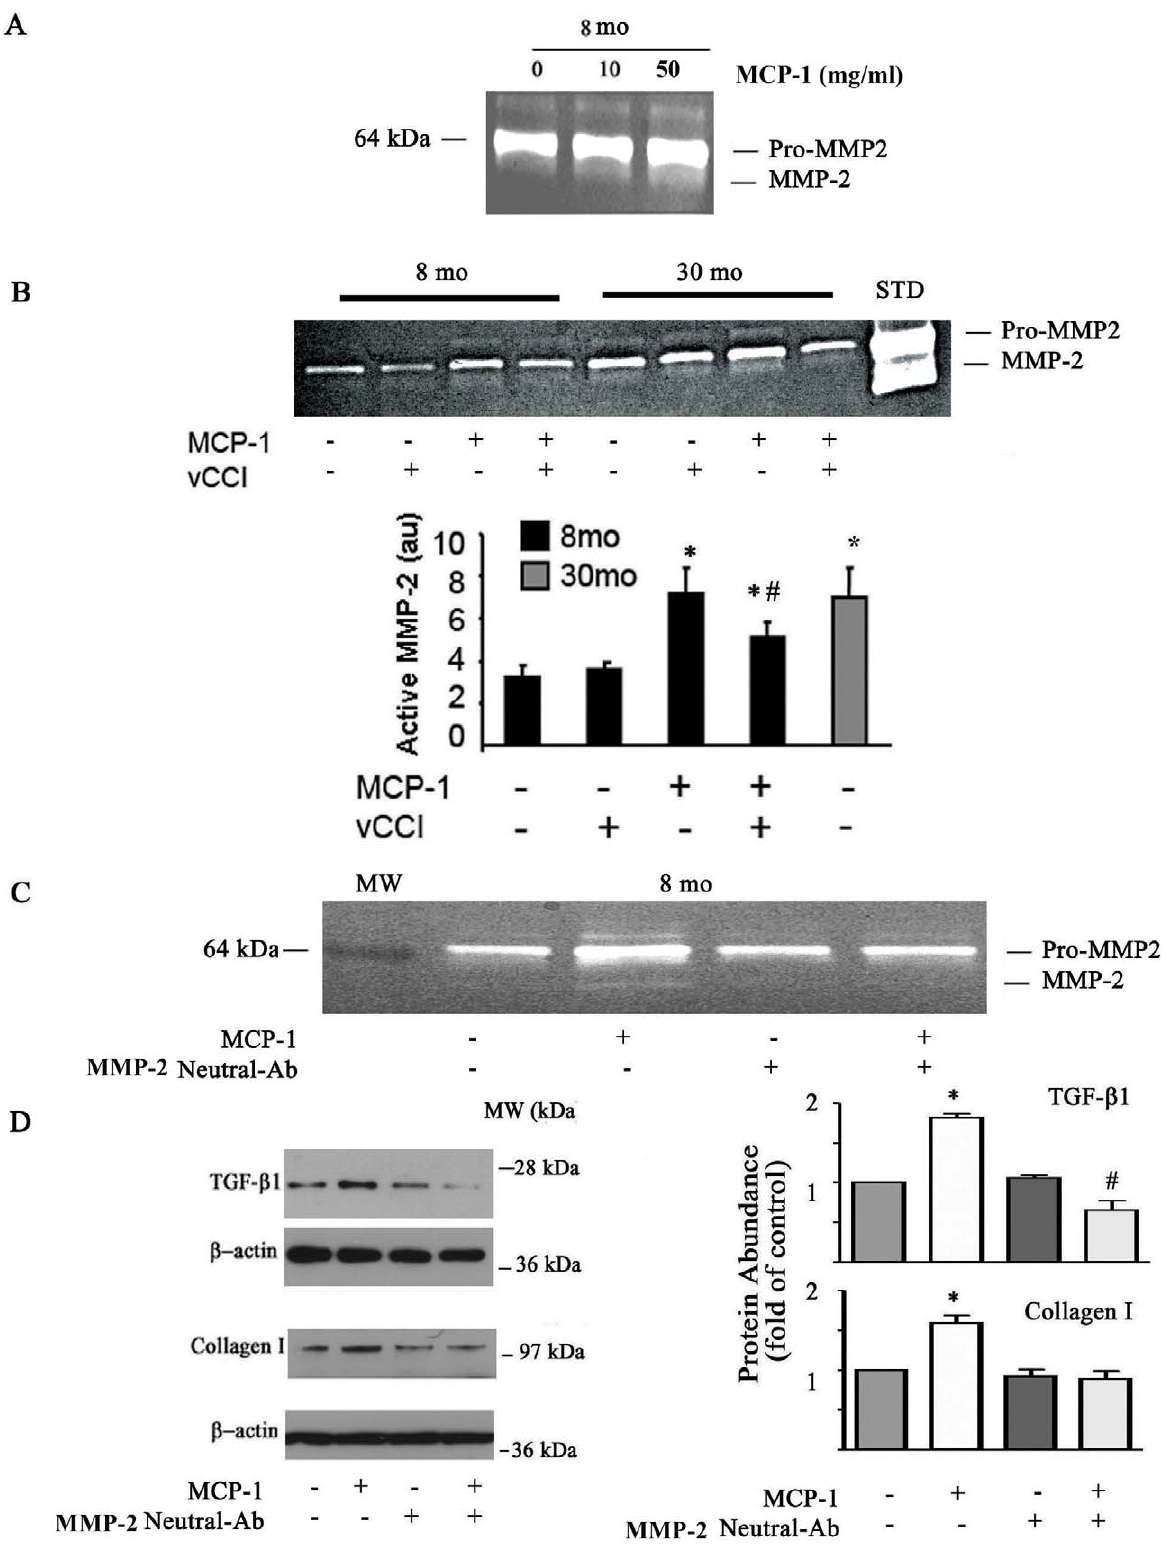
Figure 4. Profile of MMP-2, TGF- b 1 and downstream signaling molecules with aging and MCP-1 intervention. A . Gelatin zymograph. Early passage young VSMC were treated with or without MCP-1 for 24 hours. B. Gelatin zymograph (upper panel); and average data (lower panel). Early passage young and old VSMC were treated with or without MCP-1 (50 ng/ml) plus vCCI (100 ng/ml) for 24 hours. C. Gelatin zymograph (n=3). Early passage young VSMC were treated with or without MCP-1 (50 ng/ml) plus neutralizing antibody against MMP-2 (2 m g/ml) for 24 hours. D . Representative Western blots of MCP-1 and collagen I after MCP-1 treatment (left panels) and average data (right panels). Early passage young VSMC were treated with or without MCP-1 (50 ng/ml) plus neutralizing antibody against MMP-2 (2 m g/ml) for 24 hours. *p , 0.05, vs. young; # p , 0.05, vs MCP-1 treatment alone. doi:10.1371/journal.pone.0016653.g004 PLoS ONE |